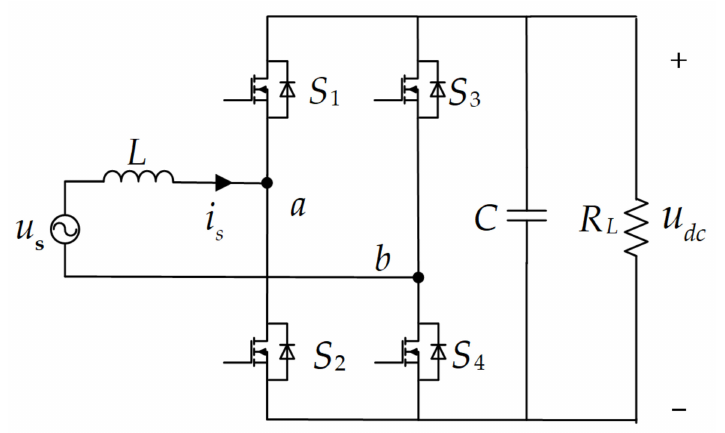
Figure 1. The topology of a single-phase PWM